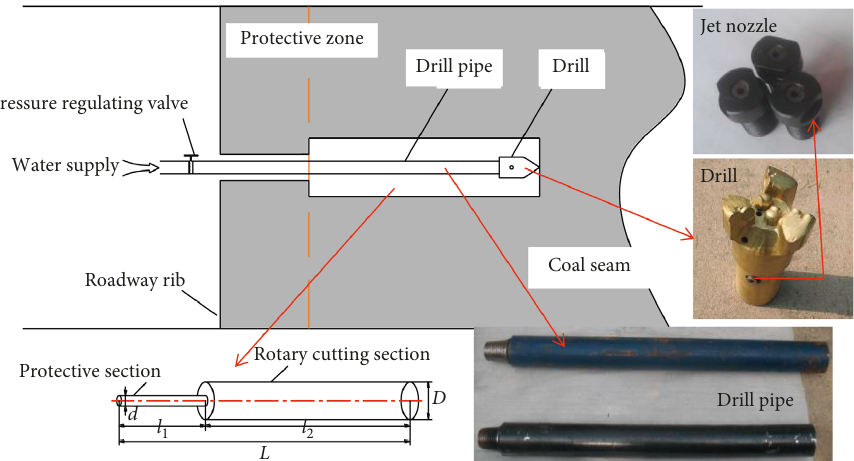
Figure 10: The schematic diagram of pressure relief zone forming after rotary cutting by pressurized water jet.